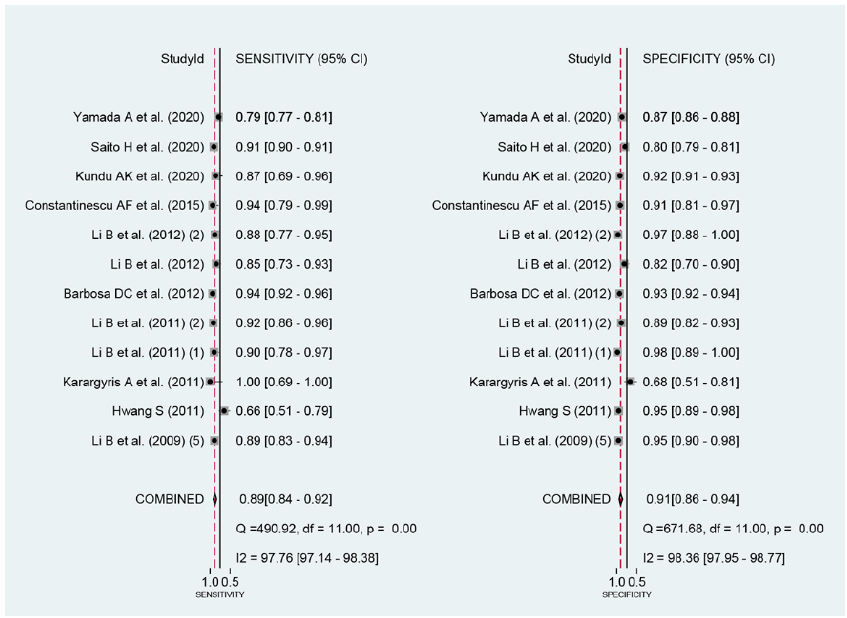
Figure 3. Coupled forest plots of the sensitivity and specificity in the computer-aided diagnosis models for the diagnosis of gastrointestinal protruded lesions in wireless capsule endoscopy images.